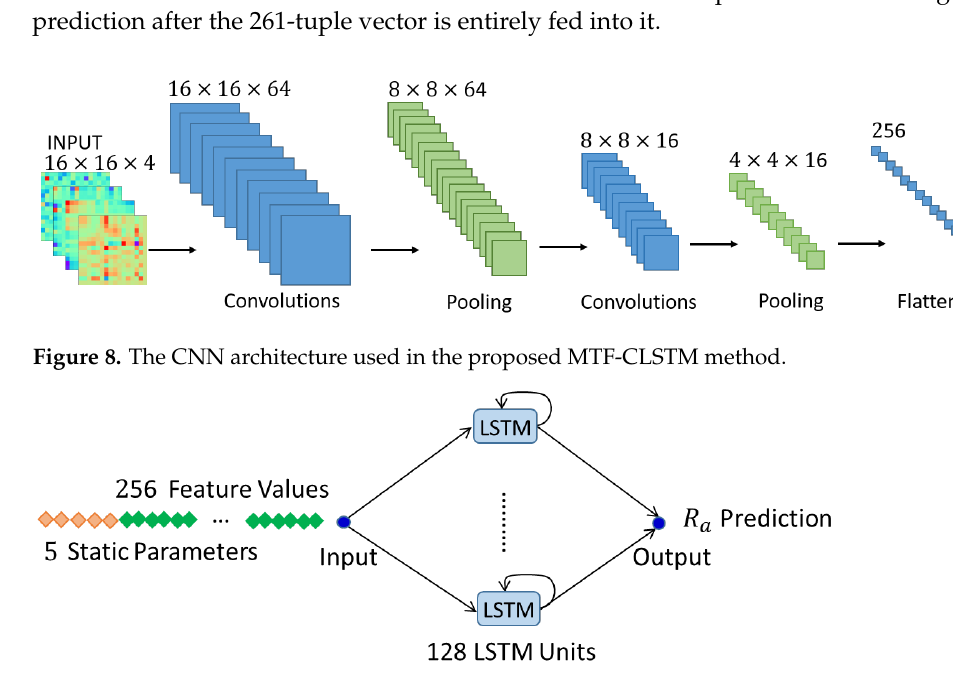
Figure 9. The LSTM architecture used in the proposed MTF-CLSTM